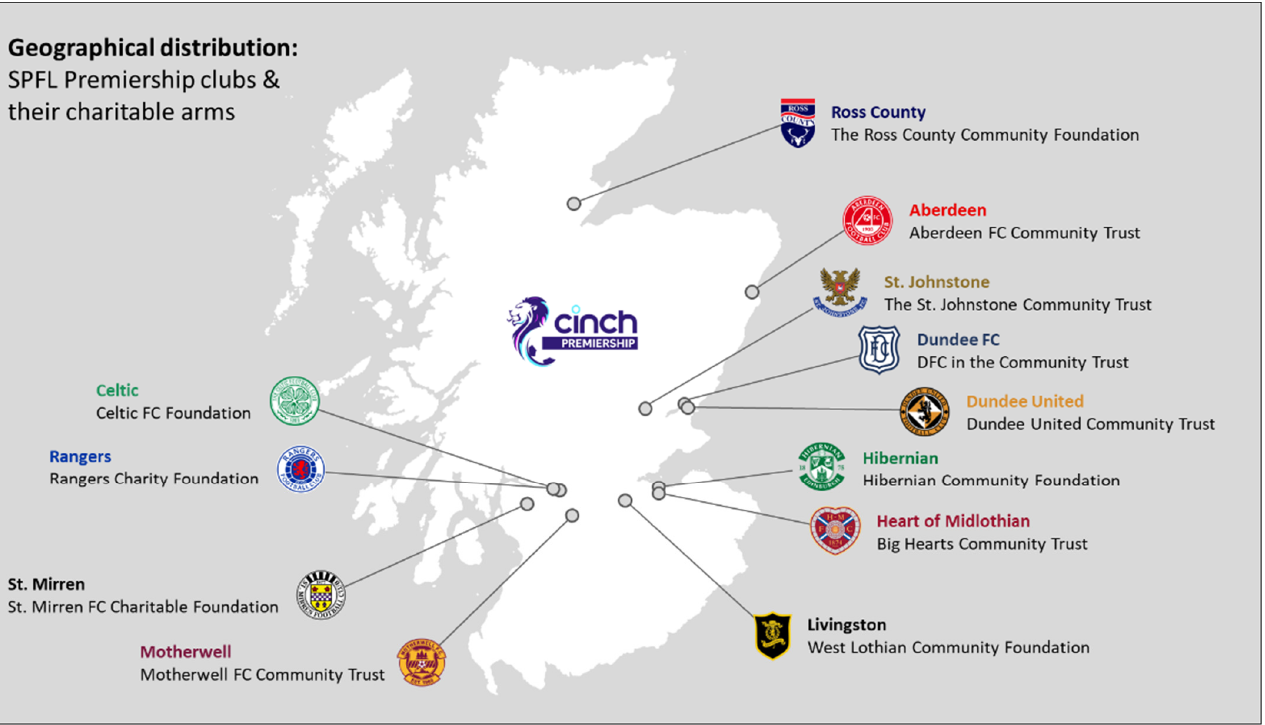
Figure 2. Map of SPFL Premiership clubs and their CSR structures.